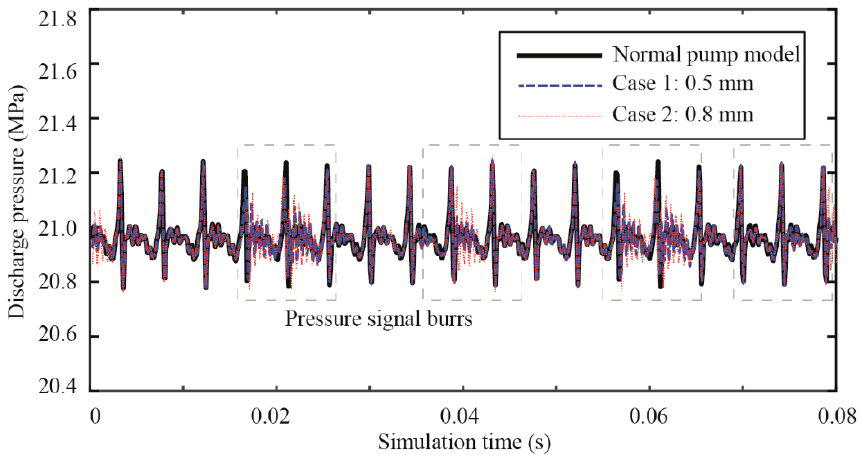
Figure 7. Comparisons of the simulated discharge pressures under different model cases.